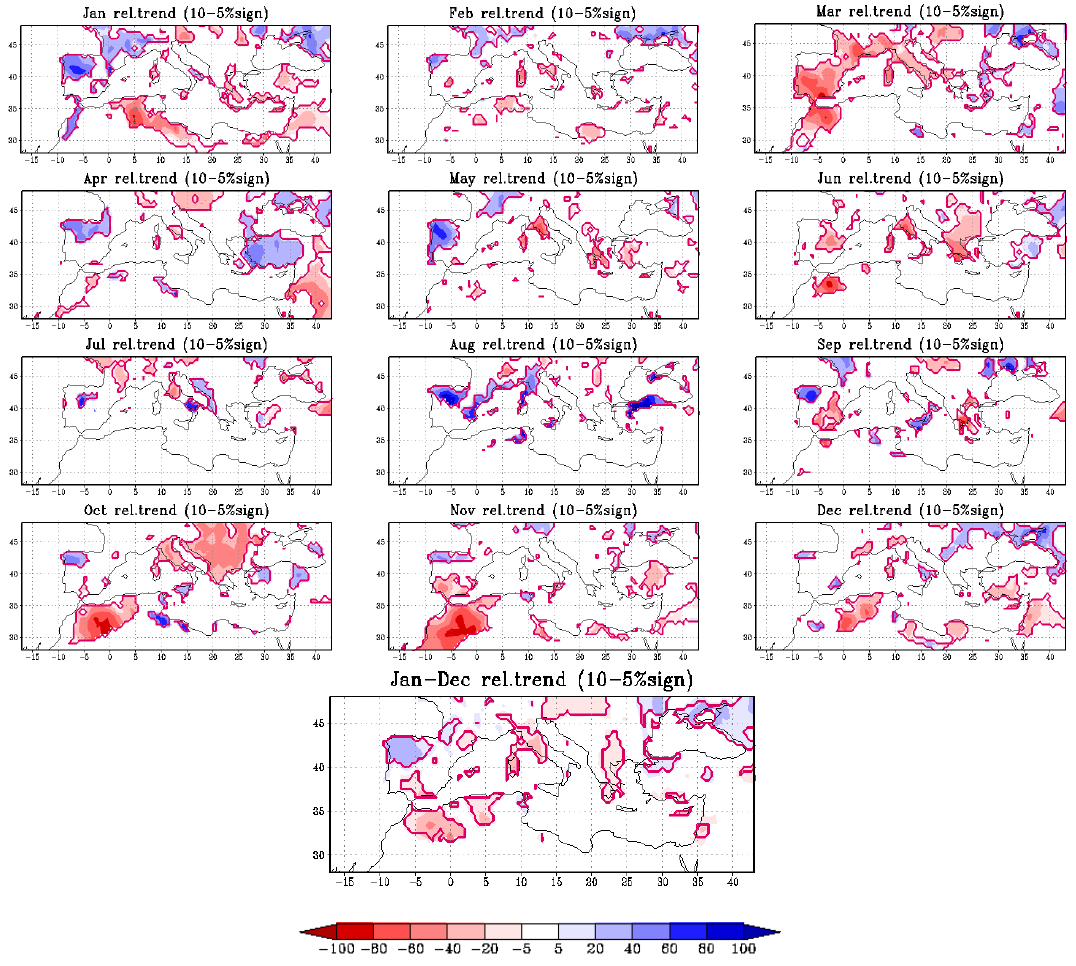
Fig. 1. Relative trends (%) of mean monthly precipitation (annual, below) in the 1901–2000 period – only areas with mean monthly precipitation above 10mm and with statistical significance of 10% achieved are represented – and circled areas are statistically significant at 5% (modified Mann-Kendall